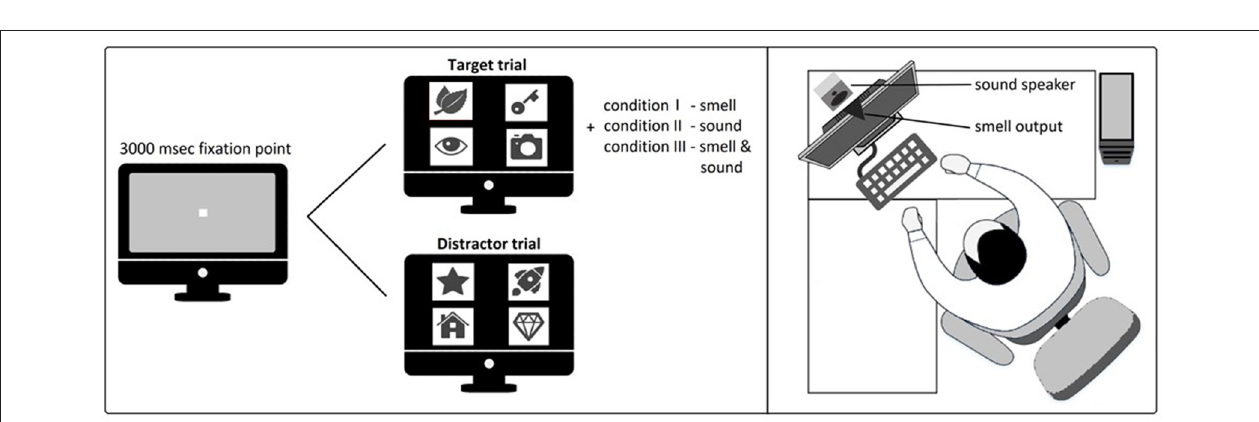
FIGURE 3 | Overview of the three main study phases. After the training phase and the control condition of the VR visual exploration task, the participants proceeded with the three experimental conditions starting from the Secondary task followed by the VR exploration task. The conditions were counterbalanced between the participants.